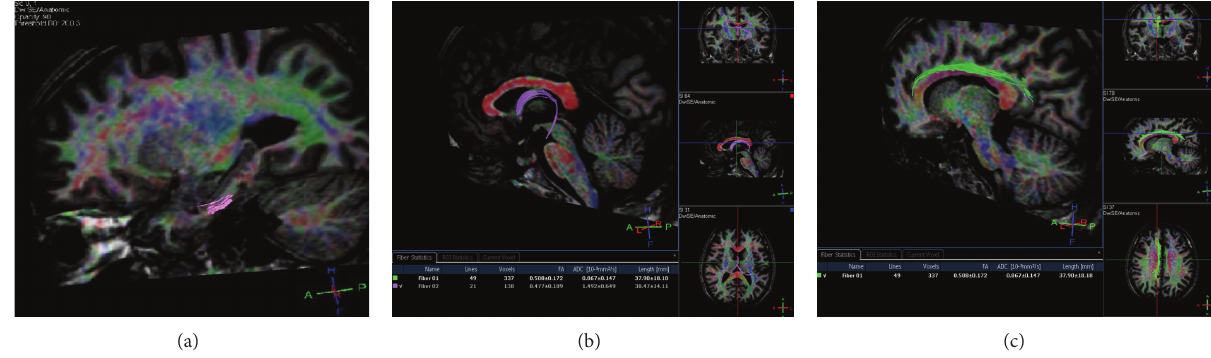
Figure 1: Fiber tracking was performed for 3D segmentation of the two major white matter tracts of the limbic system, the fornix (b), the cingulum (c), and additionally the parahippocampal gyrus (a).